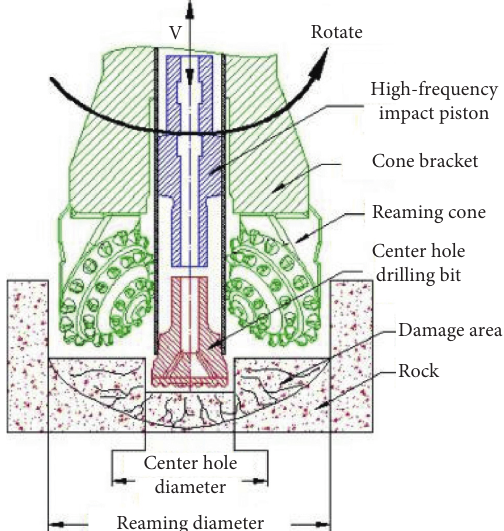
Figure 1: Structure chart of composite rock